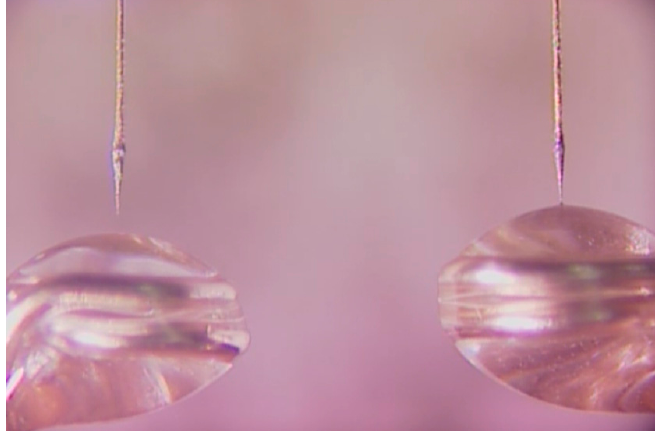
Figure 12. With improving the manufacturing yield of nanotips, two nanotips are simultaneously fabricated using two fabrication setups.